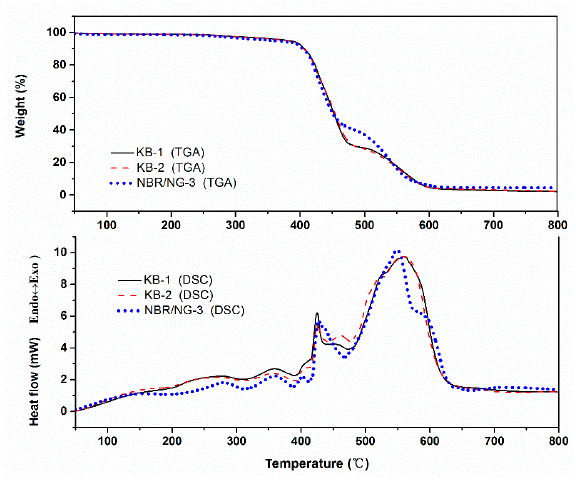
Figure 11. The TGA-DSC curves of KB-1, KB-2, and NBR/NG-3.